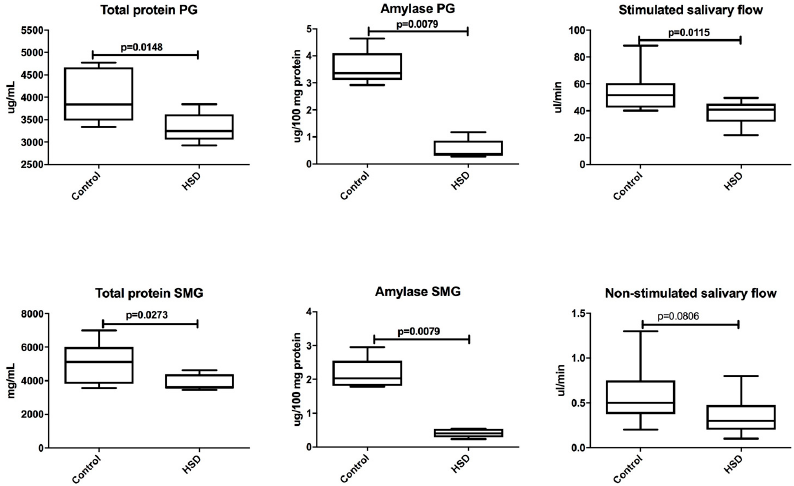
Figure 1. The effect of high-sucrose diet (HSD) on total protein, amylase activity, and non-stimulated and stimulated salivary flow rate. Abbreviations: HSD, high-sucrose diet, PG, parotid gland, SMG, submandibular gland.